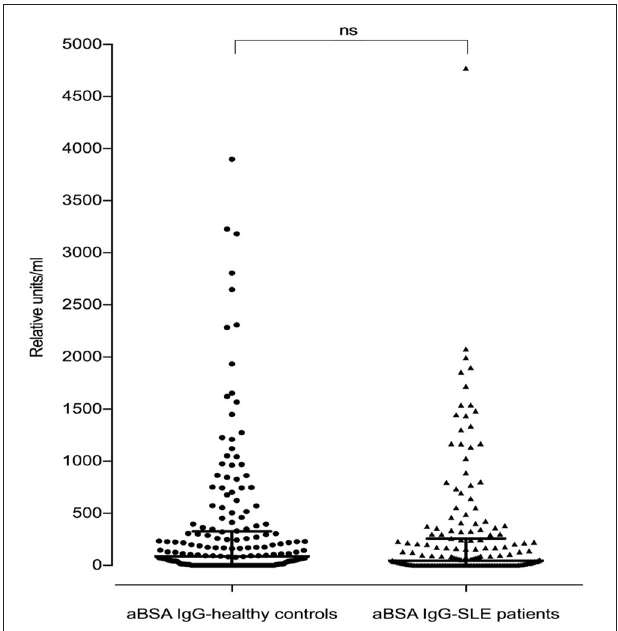
FIGURE 4 | Antibodies against bovine serum albumin in SLE patients ( n = 180) and healthy controls ( n = 188). There was no difference seen between SLE patients and healthy controls regarding anti-BSA IgG concentration ( p = 0.07, two-tailed Mann–Whitney). Bars represent median values.